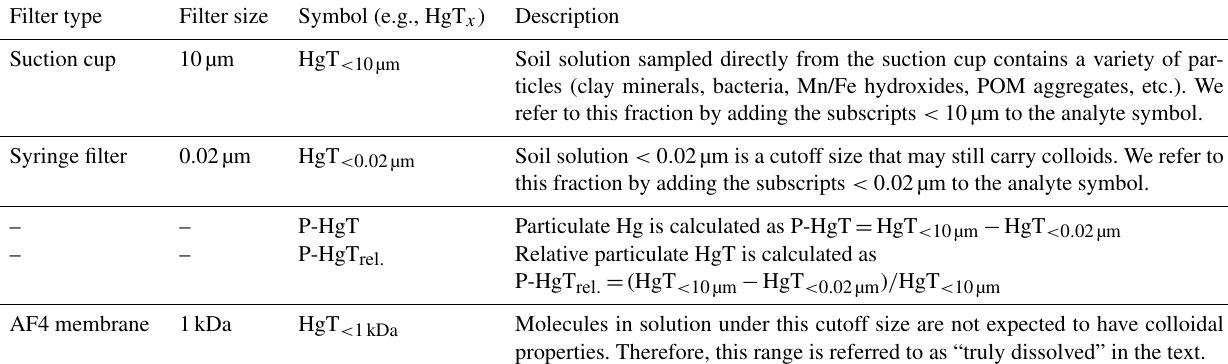
Table 2. Description of the symbols and terms used for different filter fractions in the publication. The particulate fraction is calculated as the difference of the 20nm and the 10µm filtrate concentrations.